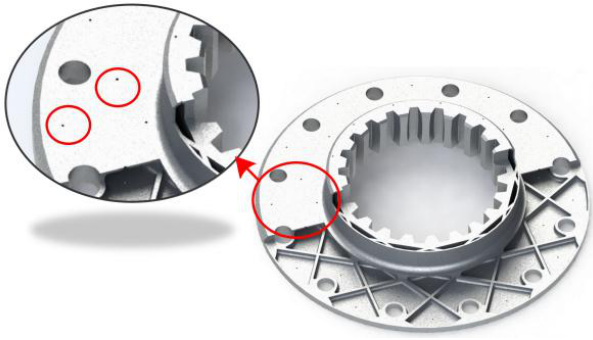
Figure 24. Final design model of the connecting plate.